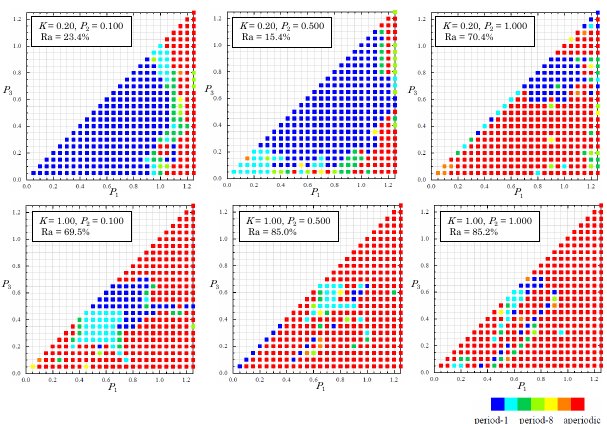
Figure 2. Parameter dependency of periodicity of slip events in Block 2 on P 1 and P 3 coordinates for K = 0 . 20 (a–c) and K = 1 . 00 (d–f) and P 1 = 0 . 100, 0.500, and 1.000. The periodicities for pa- rameter sets are discretely plotted using seven colours, which indi- cate period-1, 2–3, 4–7, 8–15, 16–31, 32–63, and aperiodic ( ≥ 64). See text for the definition of R a .